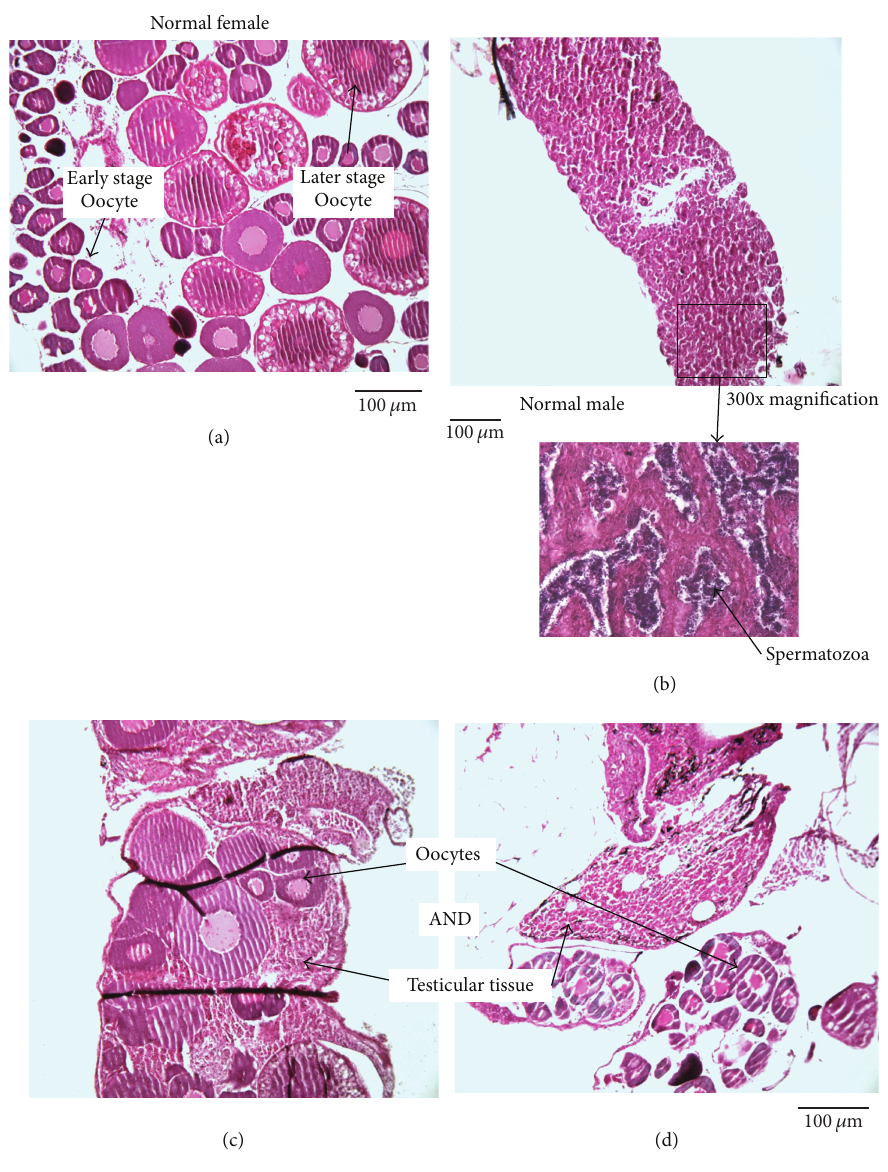
F 4: Stained sections of longnose dace gonads illustrating: (a) a normal female ovary showing different stages of oogenesis; (b) a normal male testes; (c) intersex gonads from Popson Park; (d) intersex testes from �ighway 2. All �sh were sampled from the Oldman River during August and September 2009. e dark lines in intersex gonads are wrinkles in the tissue produced by slicing. Scale bars are approximate.